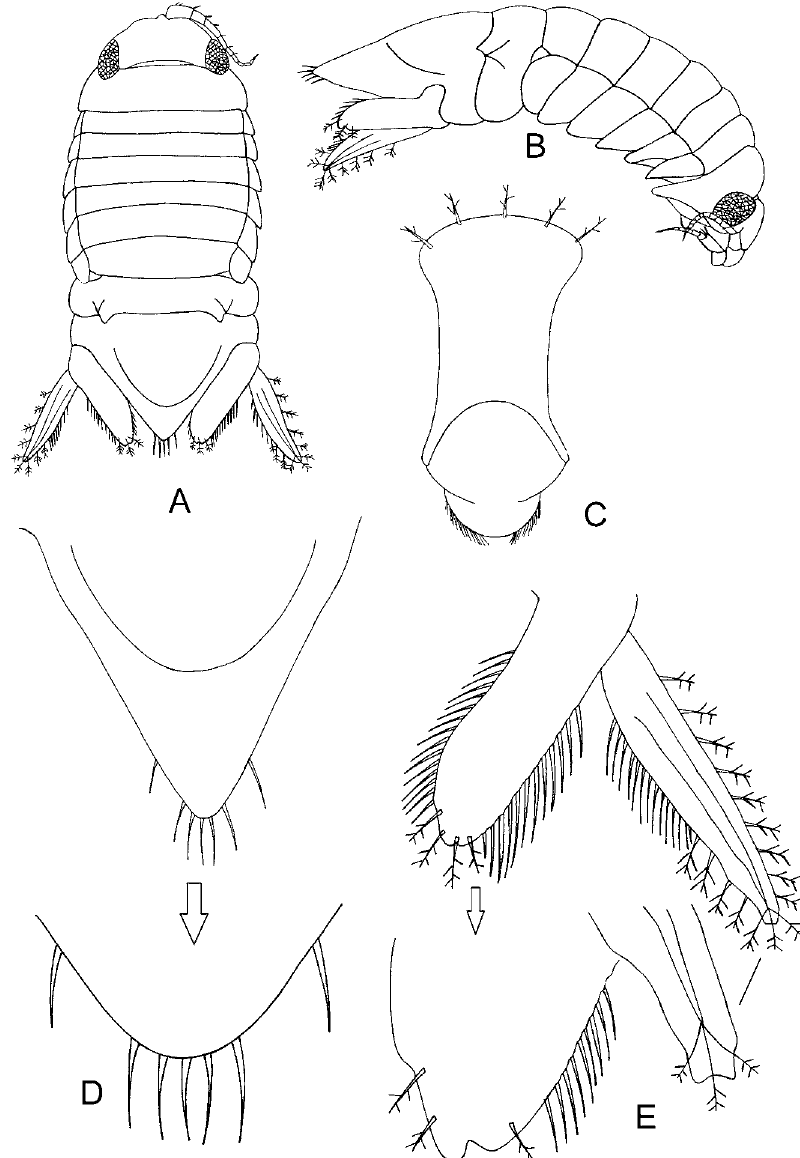
Figure 2. Sphaeromopsis jayaraji sp. nov., holotype male (2.9 mm) (PUMB 35104). A , dorsal view; B , lateral view; C , frontal lamina; D , pleotelson; E ,